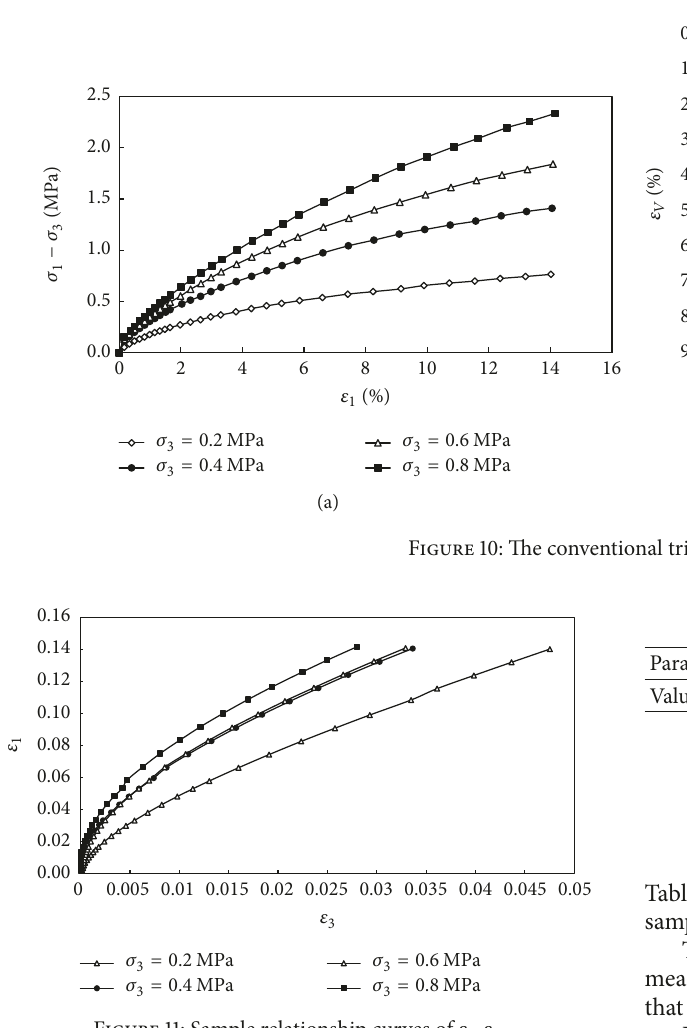
Figure 11: Sample relationship curves of 𝜀 1 - 𝜀 3 .